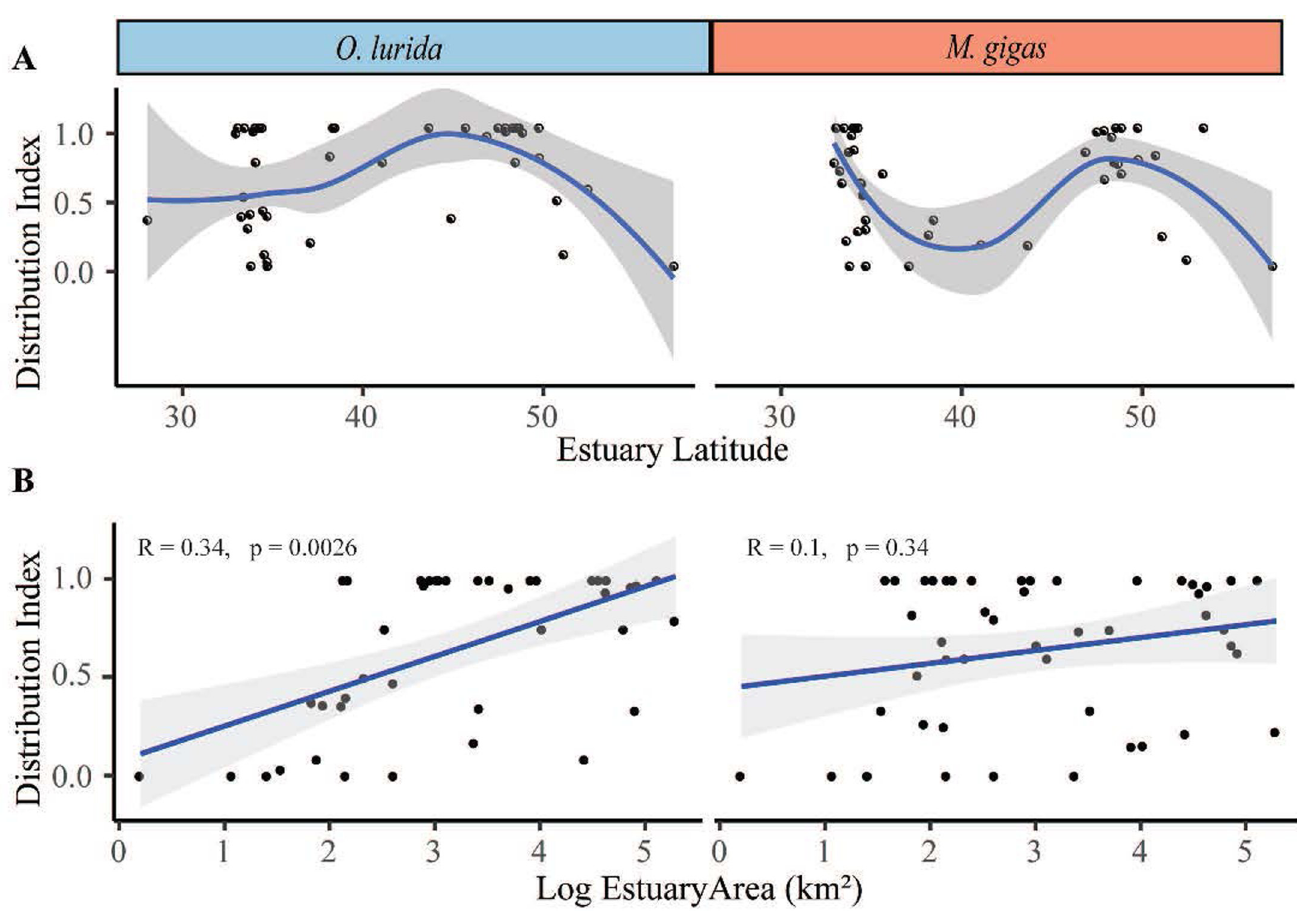
Fig 12. Relationship of estuary latitude and area with distribution index. (A) The distribution index for both O . lurida and M . gigas is plotted against latitude using local polynomial regression fitting for this distinctly non-linear relationship. (B) The distribution index for both O . lurida and M . gigas is plotted against the log 10 of the area of the estuary and fitted with linear regression; the Kendall rank correlation is shown. Each point represents a single estuary in all graphs.